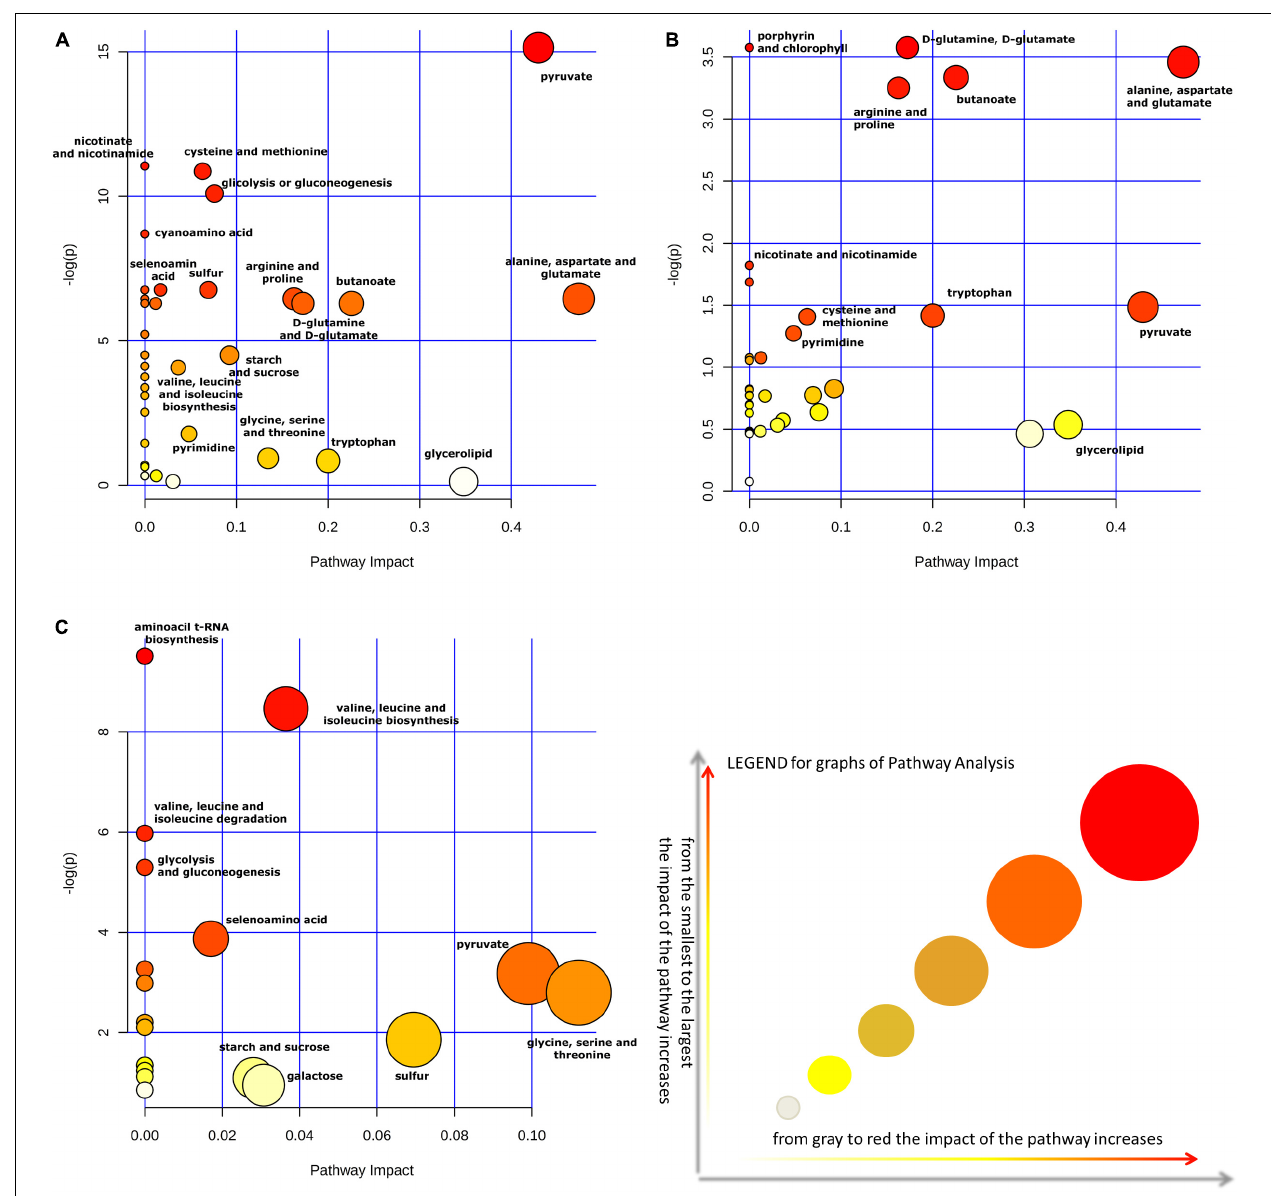
FIGURE 4 | The metabolome view shows all matched pathways, according to the p -values, from the pathway enrichment analysis, and pathway impact values from the pathway topology analysis. Impact of pathways on Lactobacillus metabolism in presence (A) or absence (B) of the supplement glycerol in the medium. Panel (C) show the impact of pathways considering only the metabolites found in greater quantity in the CFSs. All analyses of metabolite cycles were carried out using Metaboanalyst software (http://www.metaboanalyst.ca). The most significant biochemical pathways were represented with circles in different colors and sizes. In particular, smaller circles or circles in lighter colors (white < gray) indicated that the metabolite is not in the data and it is also excluded from enrichment analysis; larger circles or circle in darker colors (yellow < orange < red) indicated higher-impact metabolic